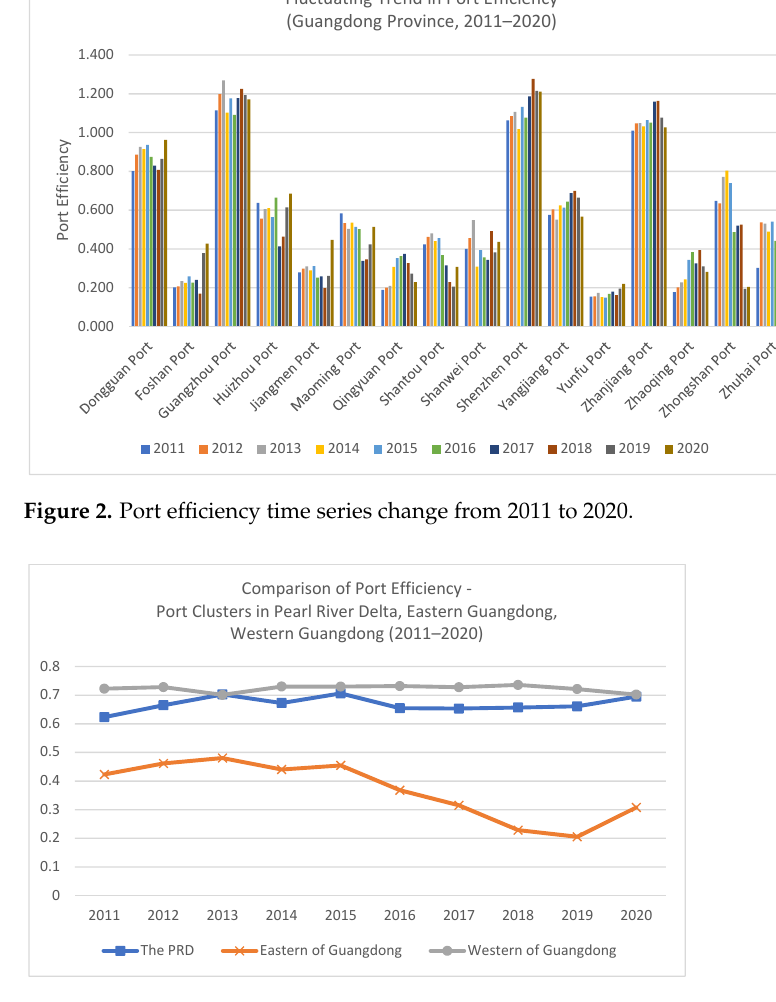
Figure 4. Spatial distribution characteristics of port efficiency.